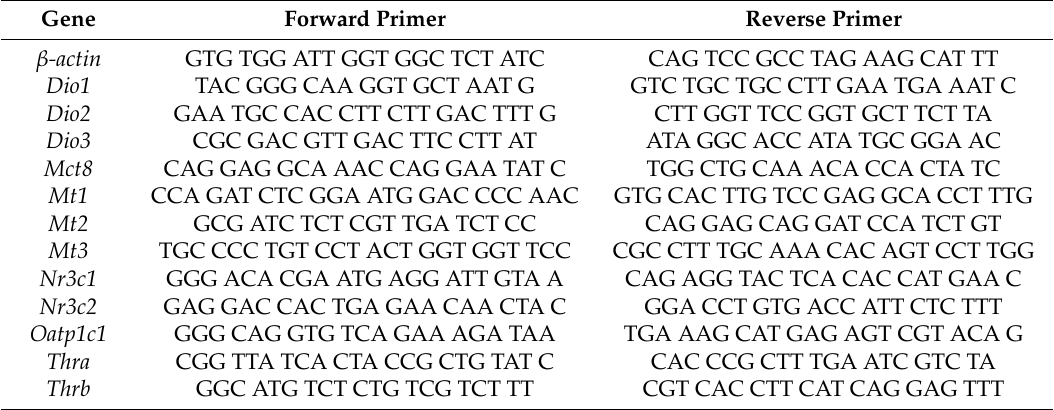
Table A1. qPCR primer sequences.